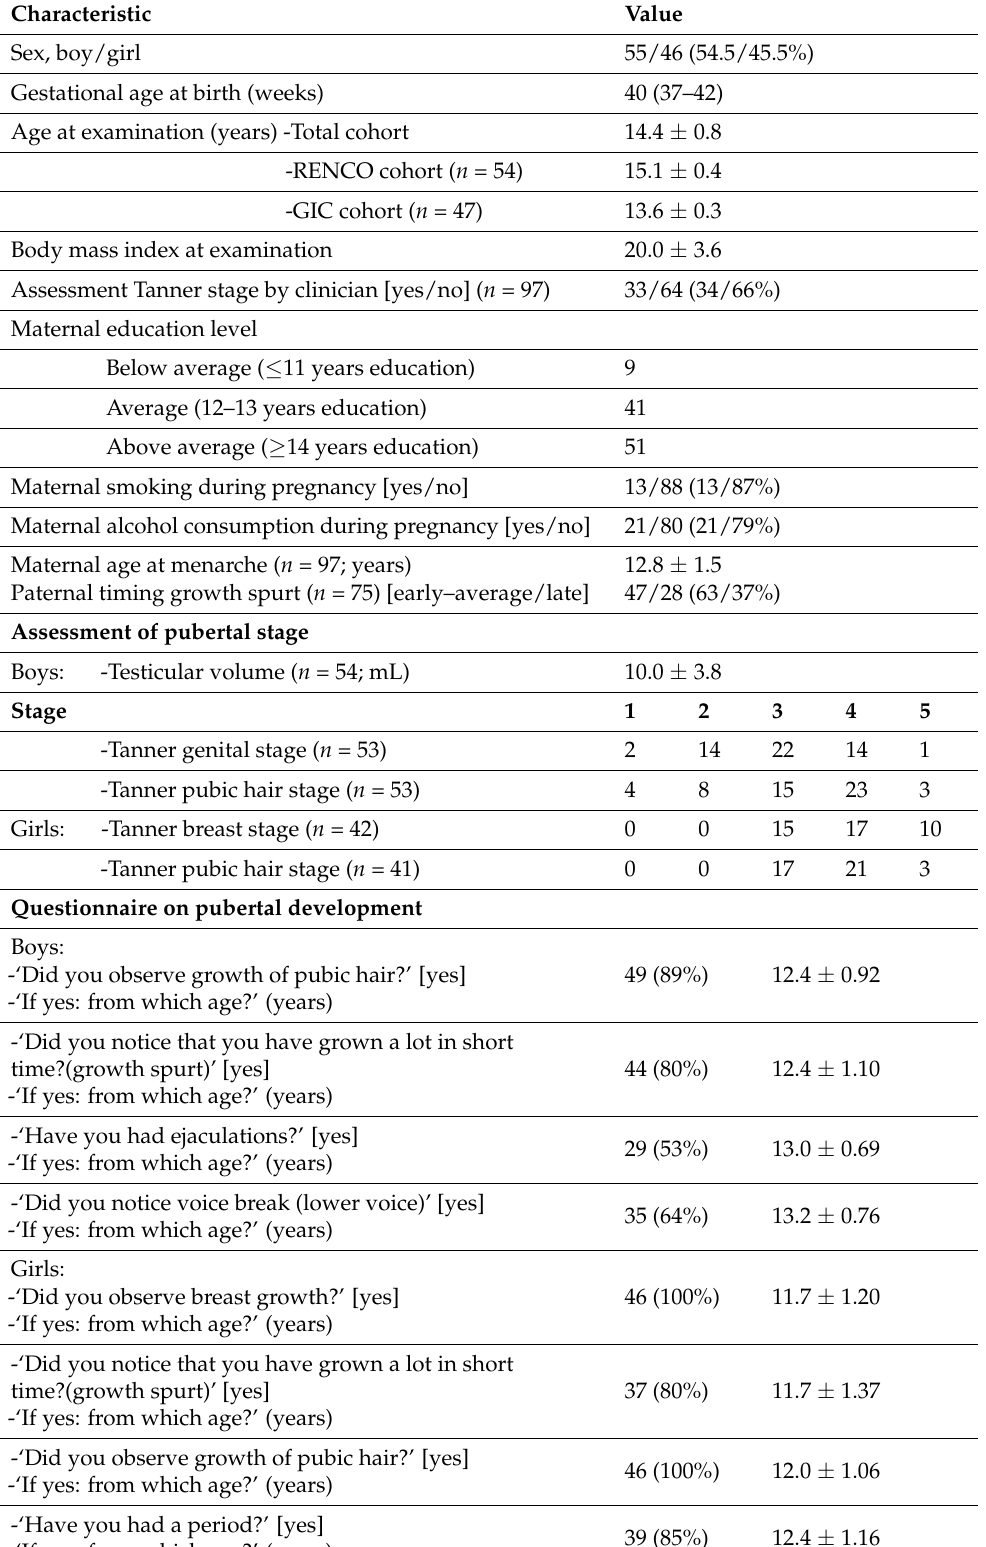
Table 1. Characteristics of the study group (N =